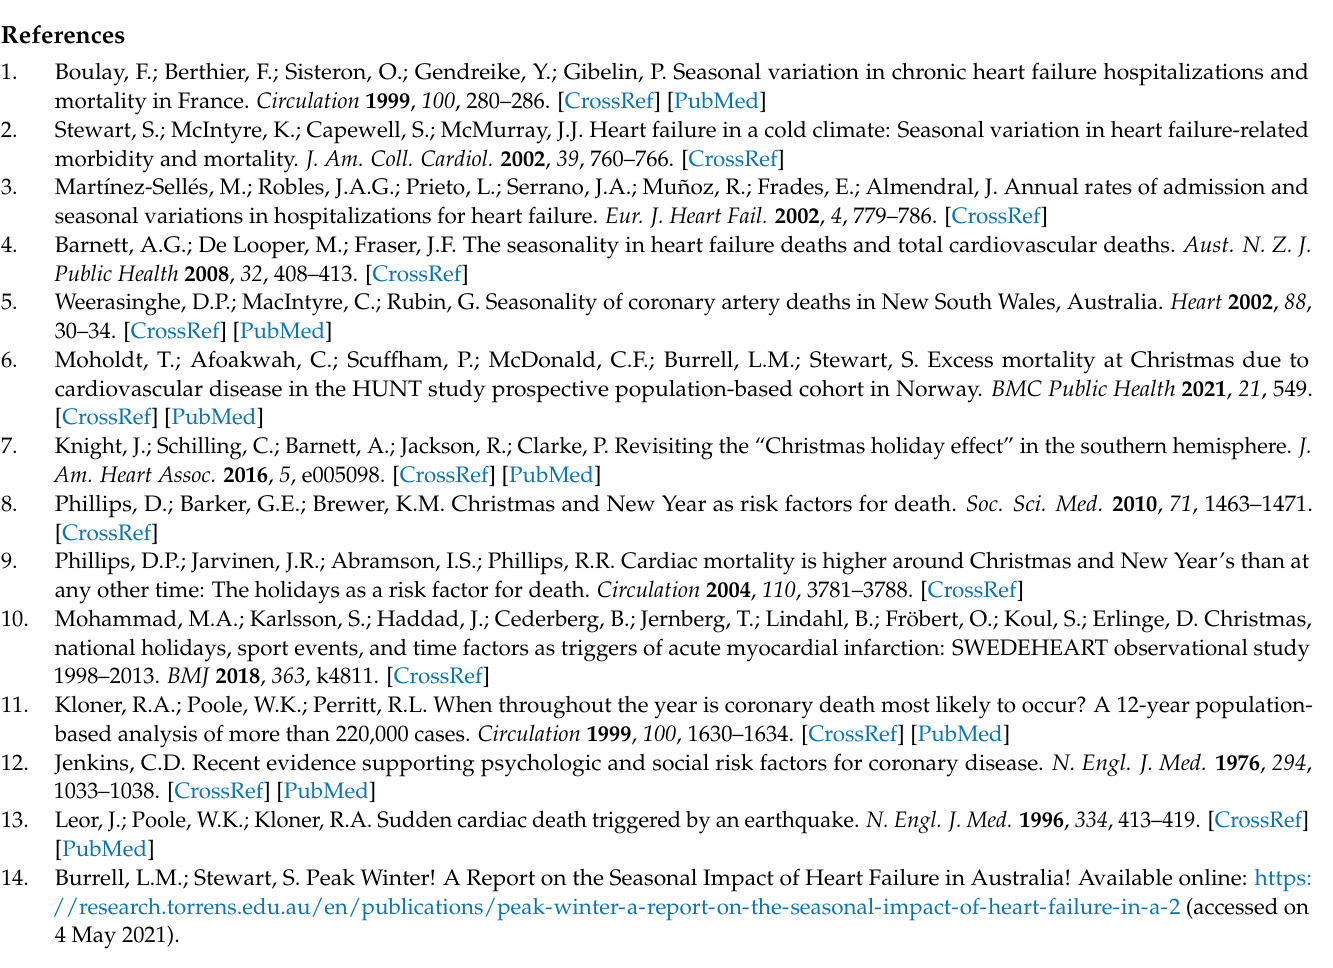
Figure A2. Sensitivity results for the peak of December holiday period.